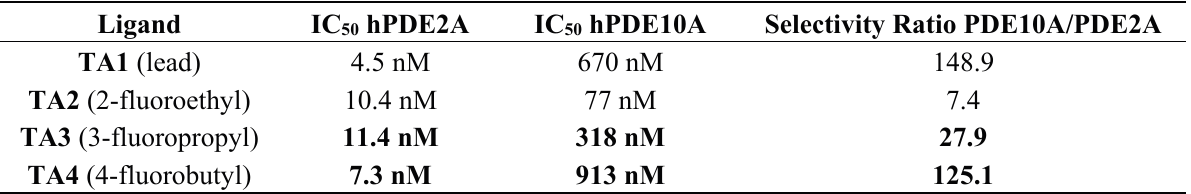
Table 1. IC 50 values of the lead compound TA1 and the novel fluoroalkylated derivatives TA2 – 4 for the inhibition of human PDE2A and human